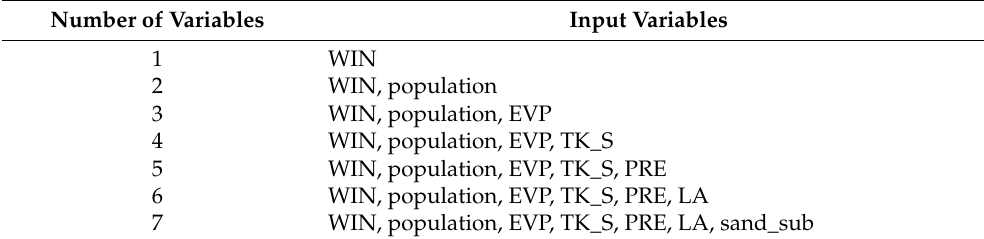
Table 7. Input combinations for each BO-GBDT